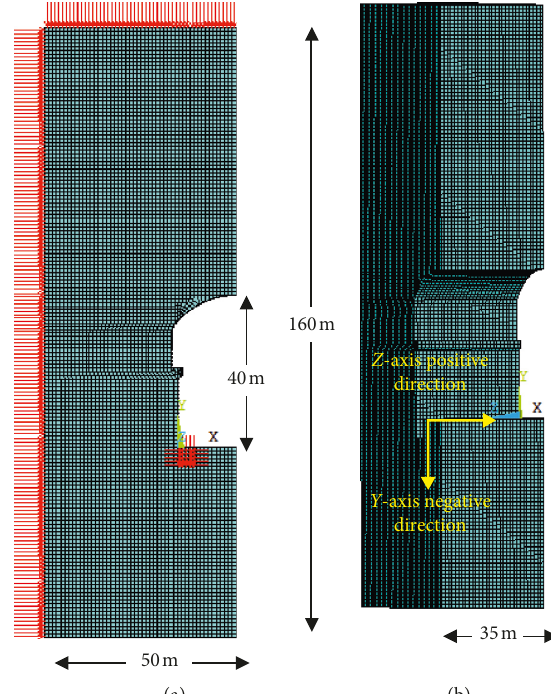
Figure 4: Front view and lateral view of the calculation model for blasting excavation of the rock anchor beam. (a) Front view. (b) Lateral view.